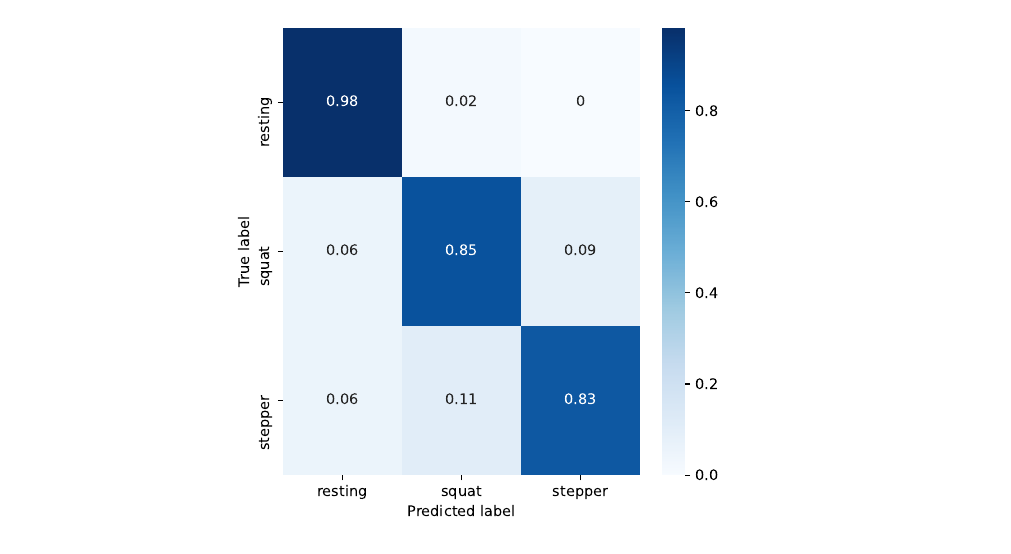
Figure 9. Confusion matrix of test data classification. Table 6. Testing accuracies of leave-one-subject-out